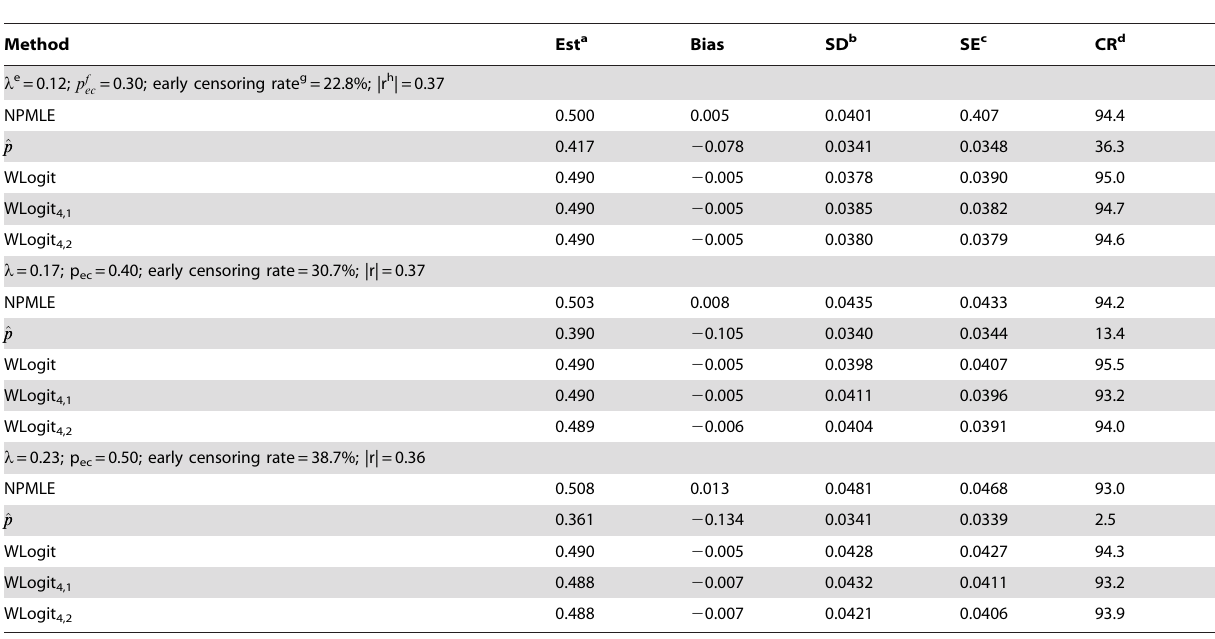
Table 3. Monte Carlo Results: Estimation of recurrence of adenomas at 3 years (true recurrence rate: 0.495) assuming independent censoring with 5 auxiliary